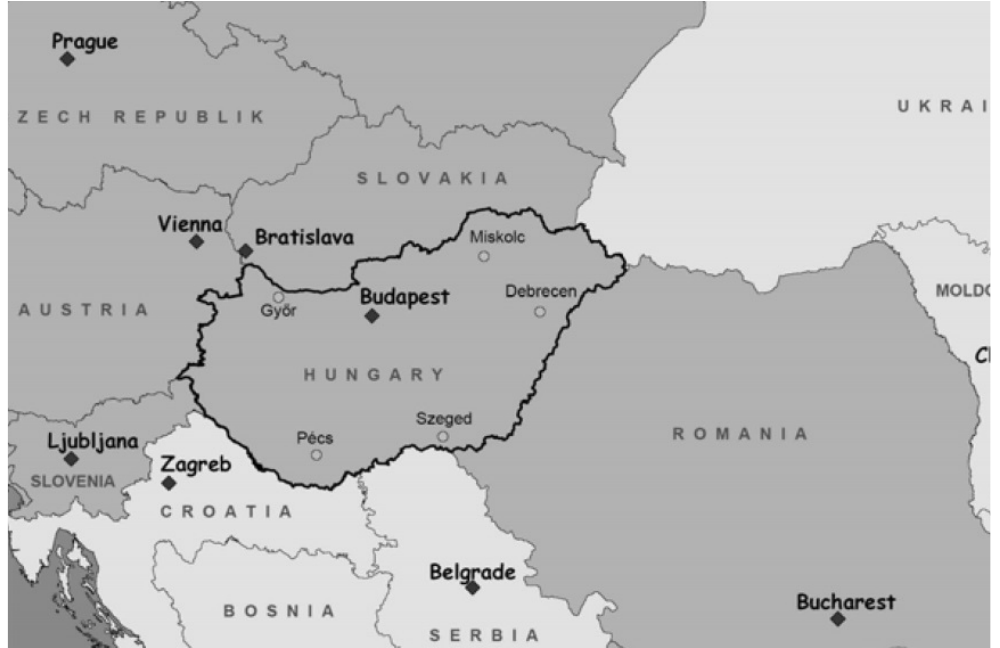
Figure 1. Location of Debrecen in Central Europe. Source: own work.